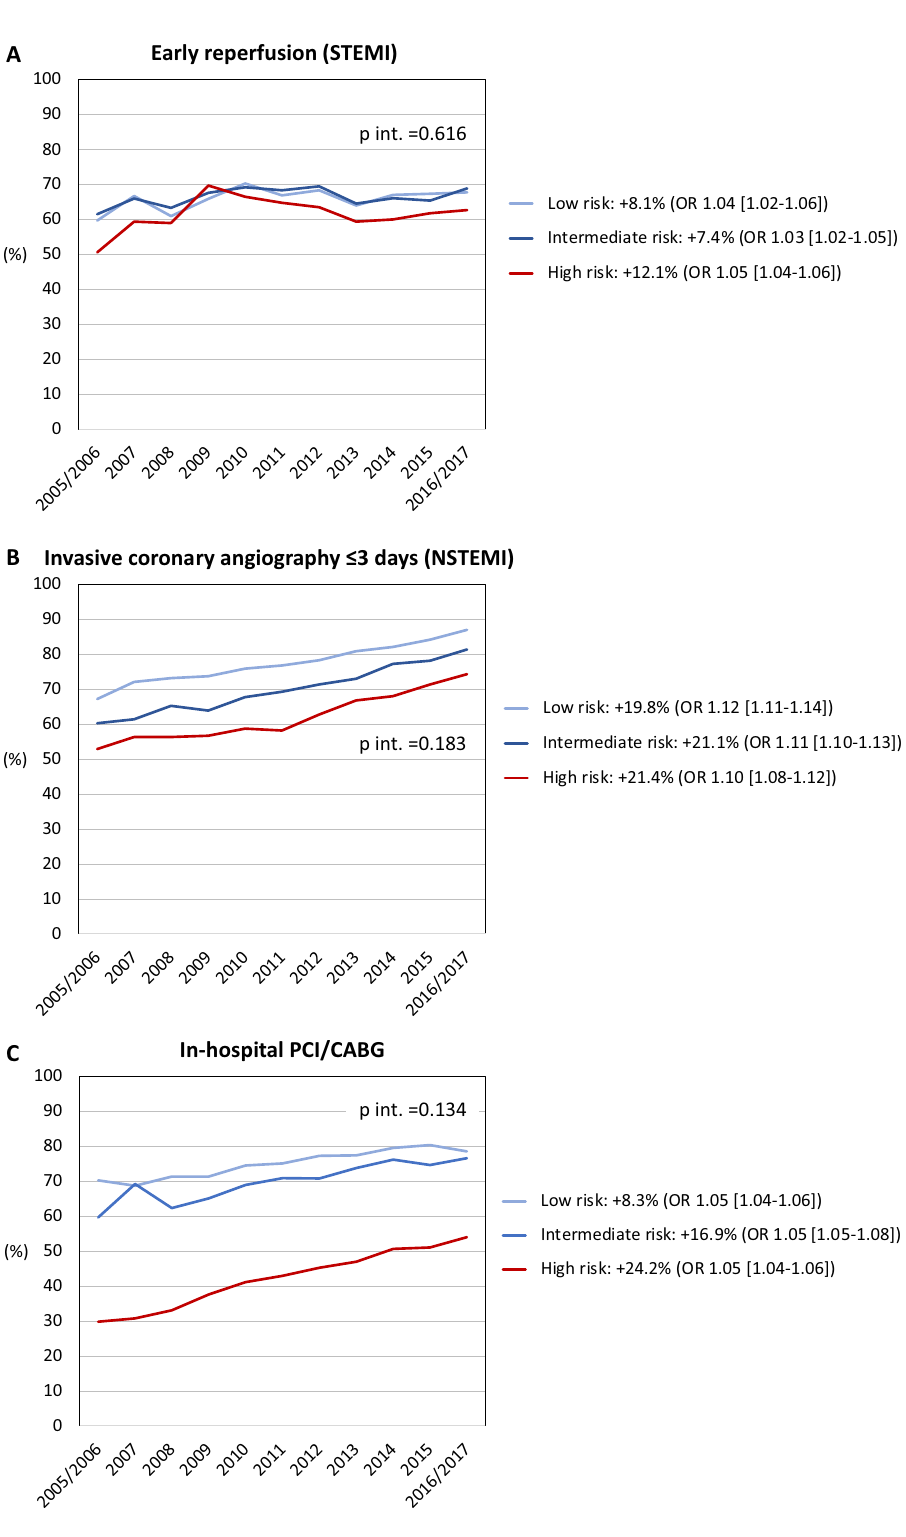
Figure 3. Temporal changes in coronary interventions. ( A ) Early reperfusion in STEMI; ( B ) coronary angiography ≤ 3 days in NSTEMI; ( C ) in-hospital PCI/CABG. Percentages refer to changes in the rates of coronary interventions from 2005/2006 to 2016/2017. p int. refers to the interaction between year of admission and risk group on the utilization of coronary interventions. Odds ratios (OR; with 95% confidence intervals) describe the adjusted associations of the year of admission (2005/2006 vs. 2016/2017) with coronary interventions. STEMI ST-elevation myocardial infarction, NSTEMI non-ST-elevation myocardial infarction, PCI percutaneous coronary intervention, CABG coronary artery bypass